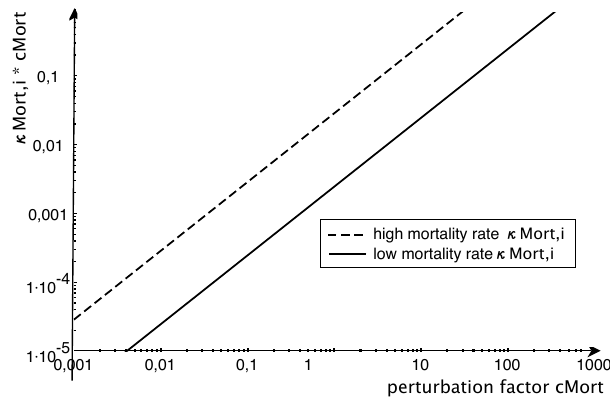
Fig. 4. The effect of perturbations on mortality (see Eq. 6) for a PPS with low and high mortality